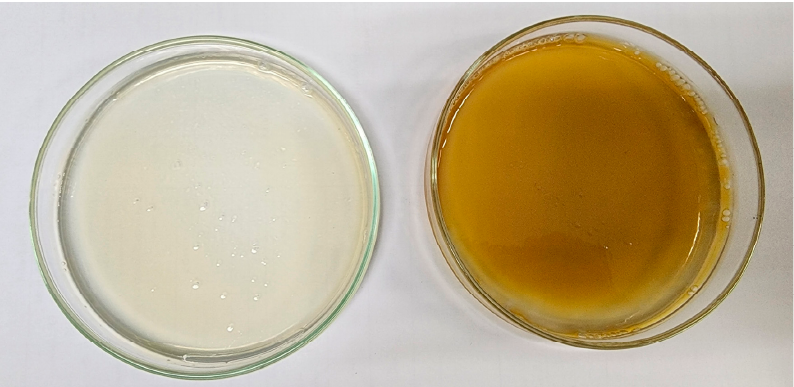
Figure 8. ( left ) Blank film and ( right ) topical film containing silver-nanoparticle-complexed G. applanatum .